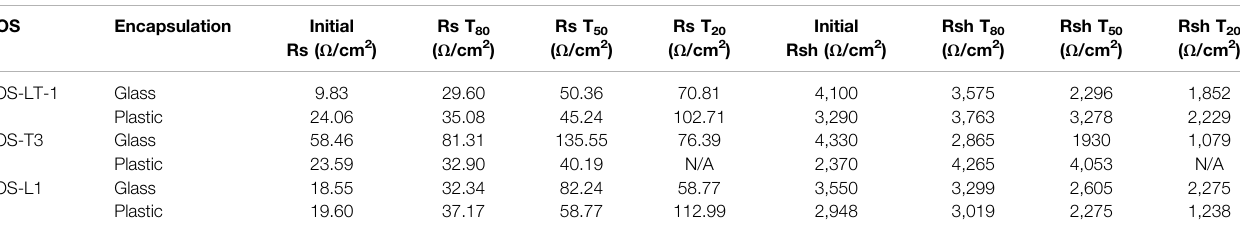
TABLE 5 | Summary of the evolution of the series and shunt resistances at different device ’ s lifetime. ISOS Encapsulation